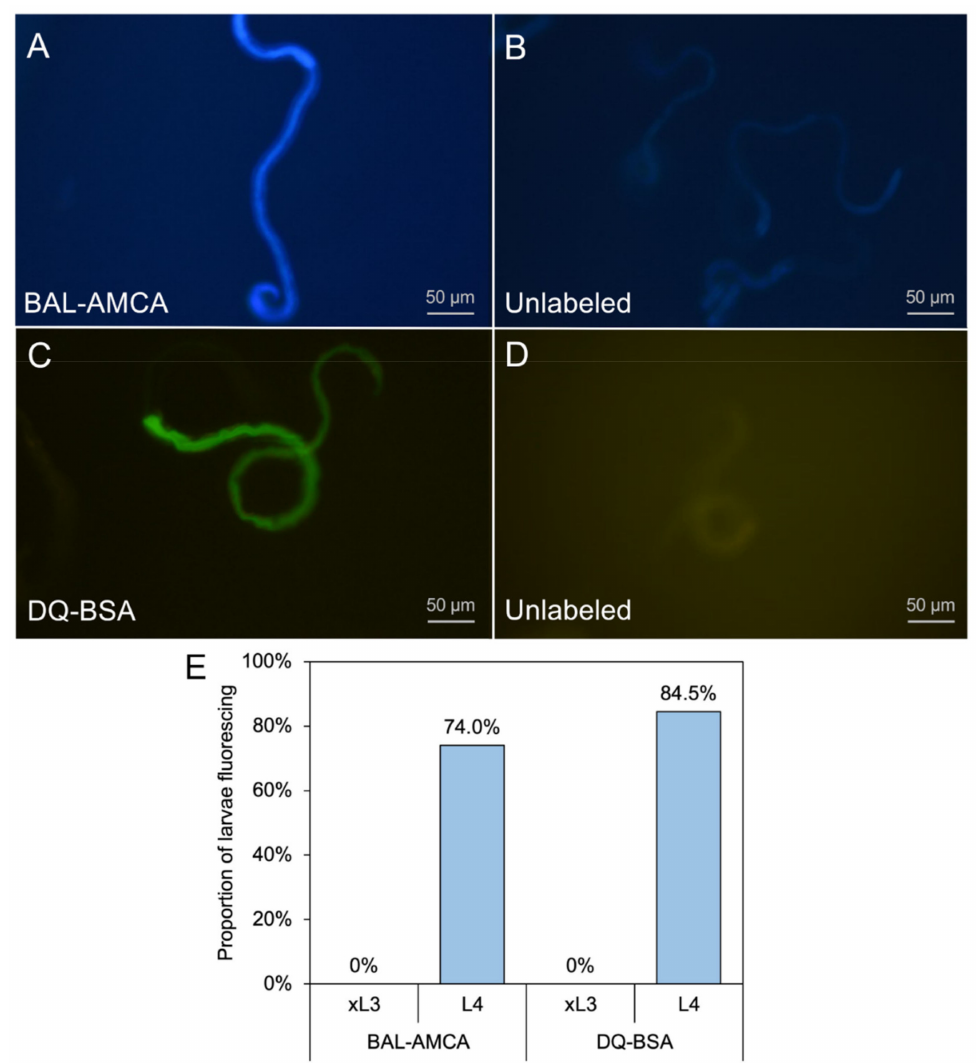
Figure 1. Fluorescent probes demonstrate larval ingestion in L4 H. contortus . Beta-ala,lys-AMCA (BAL-AMCA) ( A ), or DQ-Bovine Serum Albumin (DQ-BSA) ( C ) labeled larvae shows probe staining in the intestine. Unlabeled controls ( B , D ), respectively) larvae lack staining. ( E ) The proportion of xL3 and L4 larvae with staining by each probe after 4 h